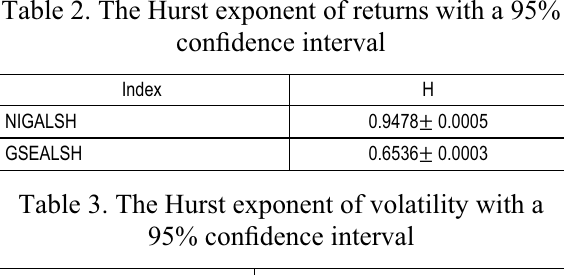
Table 2. The Hurst exponent of returns with a 95%